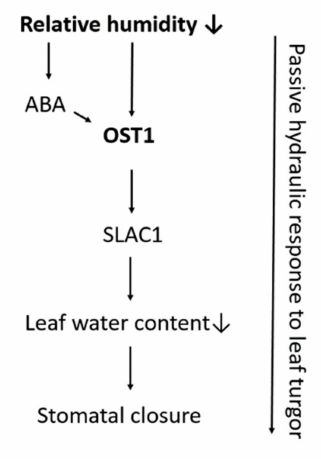
Figure 8. Hypothetical model for relative humidity (RH)-induced stomatal closure. The protein kinase OST1 is required for RH-induced stomatal closure, with either an ABA-dependent or ABA-independent activation. A passive hydraulic response to a reduced leaf turgor pressure is also possible under a low ambient RH. Adapted from Merilo et al.